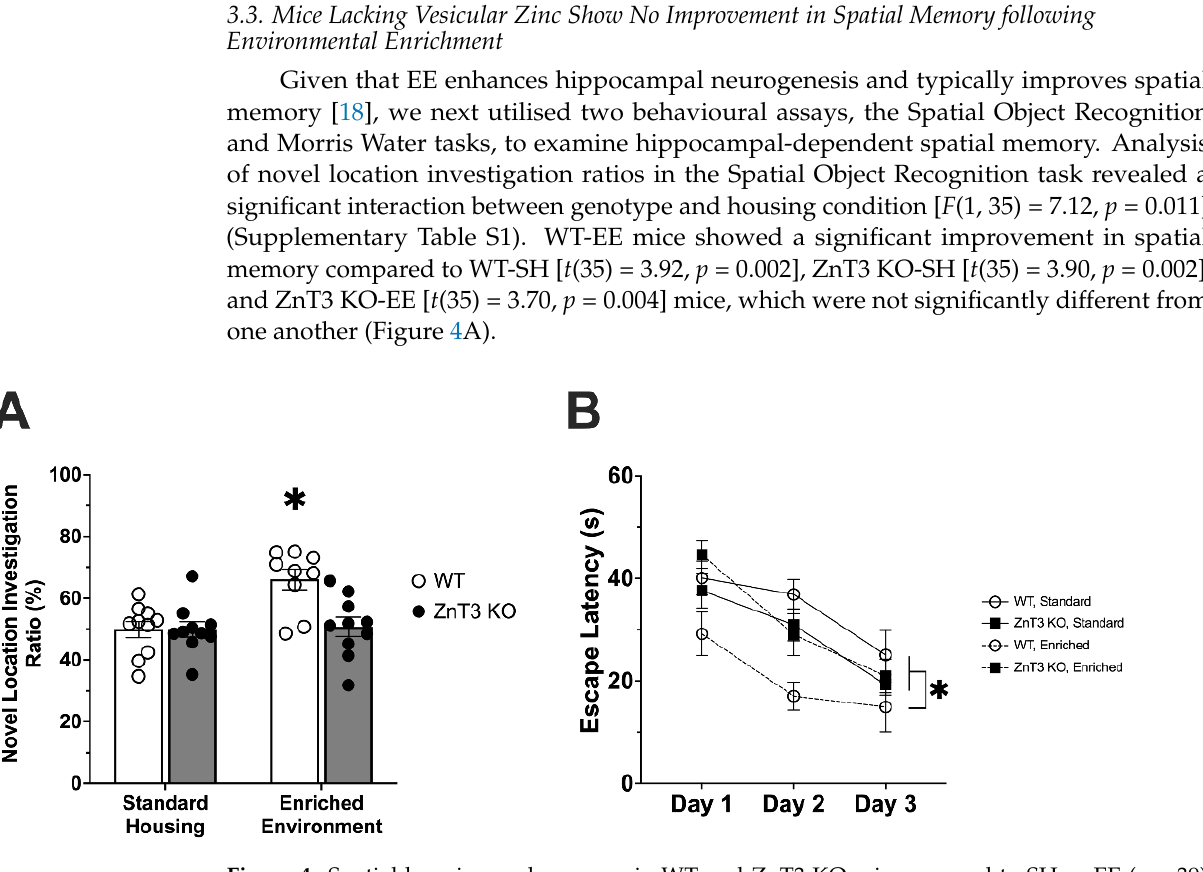
Figure 3. Cell death and granule cell layer volume in WT and ZnT3 KO mice exposed to SH or EE ( n = 23). ( A ) A representative photomicrograph of cresyl violet-stained sections of the granule cell layer reveals pyknotic nuclei that are characteristic of dying cells (arrow). ( B ) The level of cell death did not differ between WT and ZnT3 KO mice in SH. EE significantly decreased cell death in WT mice but had no effect in ZnT3 KO mice. ( C ) There were no differences in granule cell layer volume between WT and ZnT3 KO mice in the SH condition. Granule cell layer volume is significantly increased in WT but not in ZnT3 KO mice exposed to EE. Error bars represent ± standard error of the mean. * indicates p < 0.001.